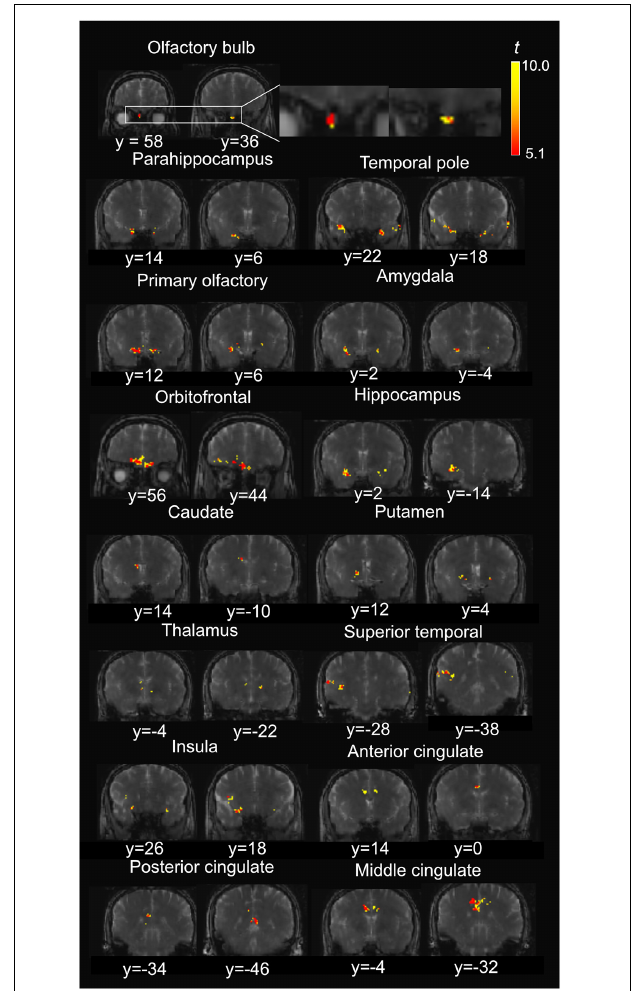
FIGURE 4 | Representative positive activation maps from T2prep BOLD fMRI scans during the olfactory stimulation from one participant. The t -scores of significantly positively activated voxels are overlaid on the T2prep BOLD images from the same participant. Two slices were shown for each ROI. But the entire activated cluster in each ROI covered more